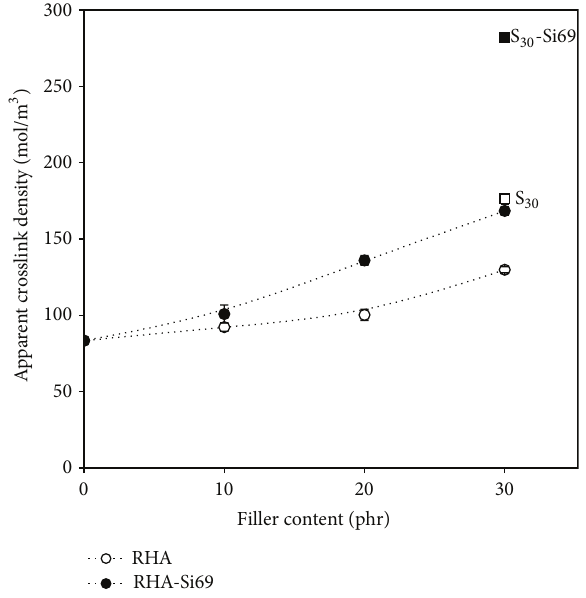
Figure 11: Apparent crosslink densities of gum and filled ENR-25 vulcanizateswithvariousRHAcontentsand30 phrofsilicawithand without silane coupling agent (Si69).